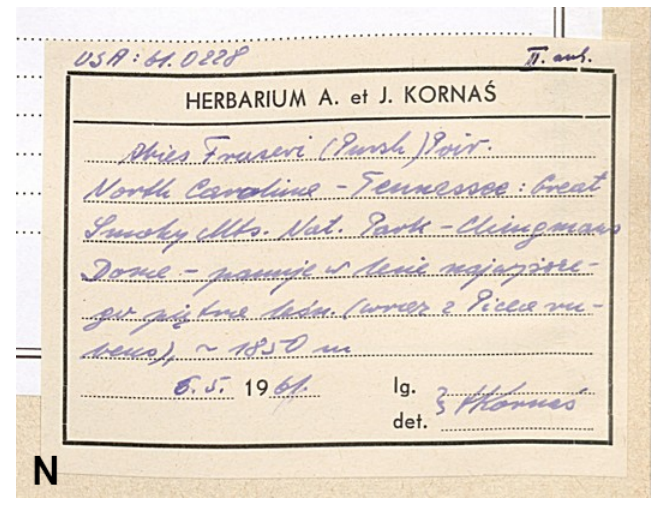
Fig. 2 Examples of labels of Pinaceae family specimens in KRA from the following collectors: ( A ) J. É. Gay, ( B ) F. A. Müller, ( C ) Ph. A. Ch. Endres[s], ( D ) F. M. Liebmann, ( E ) F. Berdau, ( F ) A. J. Śleńdziński, ( G